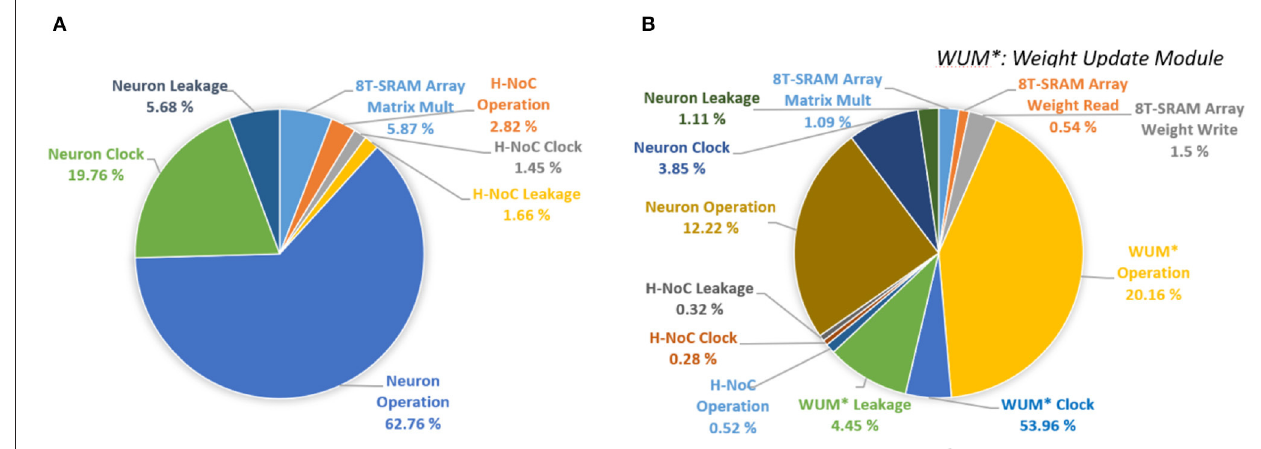
FIGURE 16 | Power breakdown of MONETA. (A) inference mode and (B) training mode.